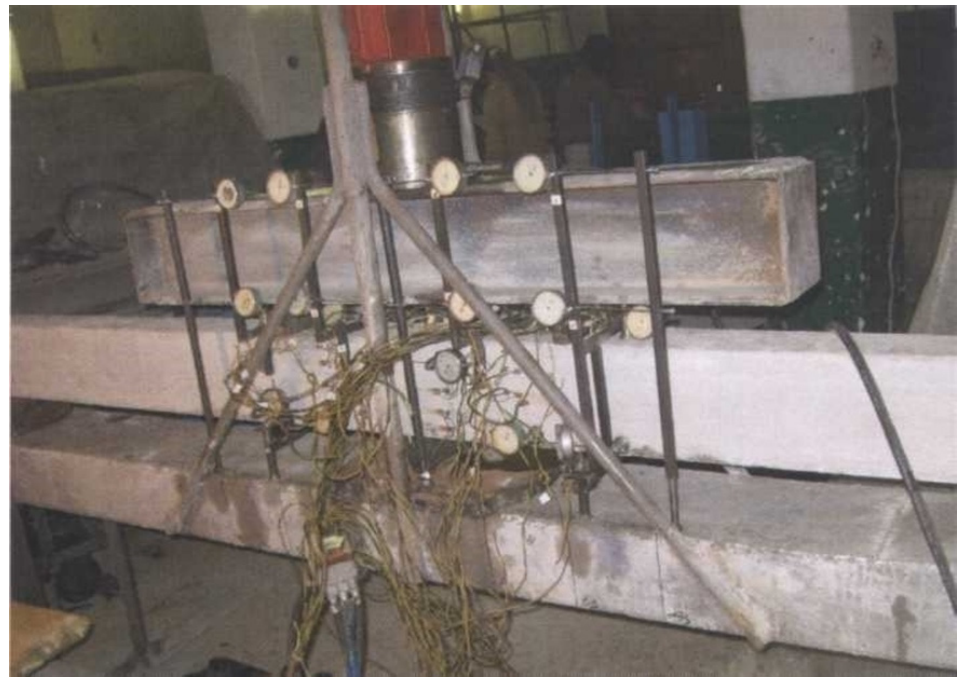
Figure 2. General view of the test of a continuous double-span beam.